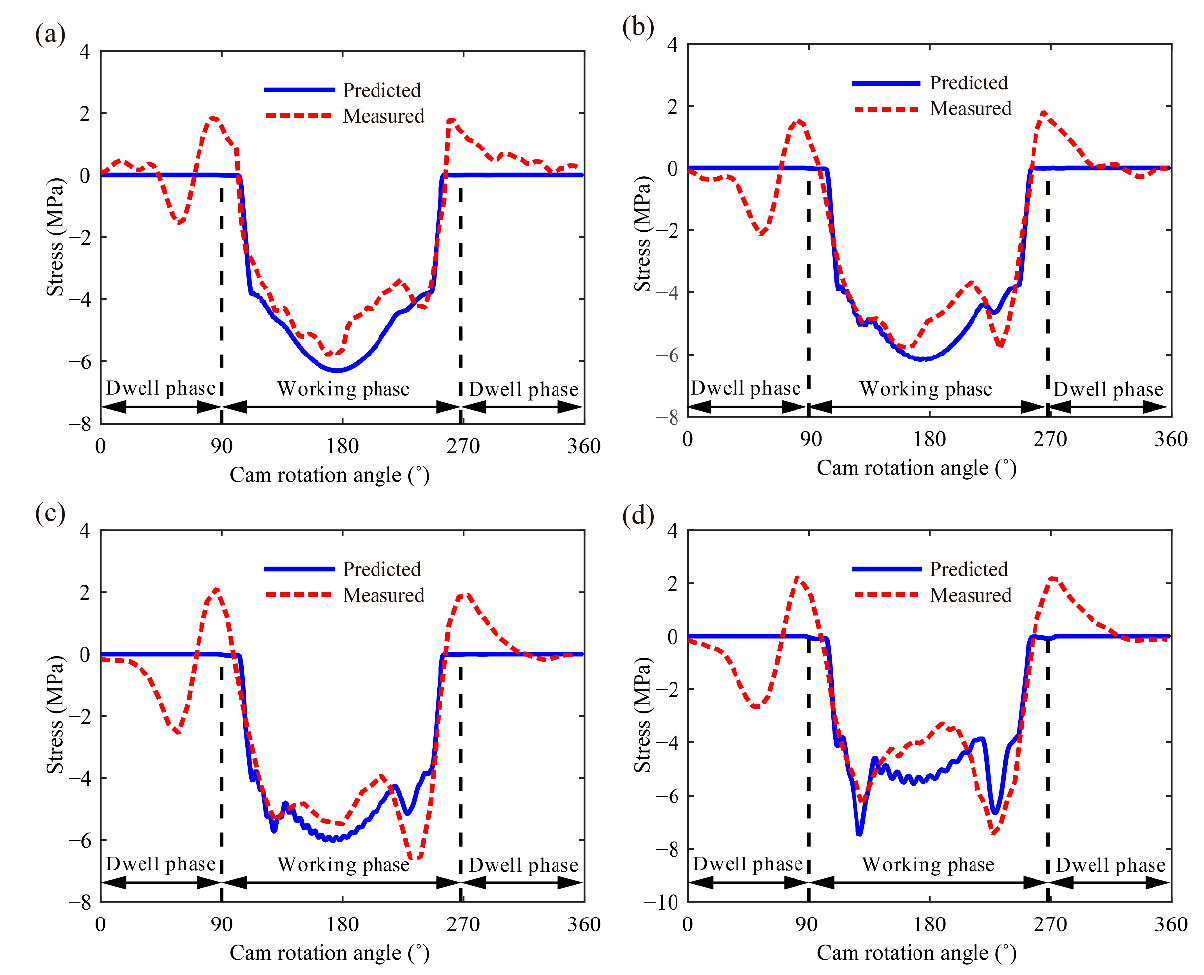
Figure 6. Predicted and measured stresses at ( a ) 600, ( b ) 900, ( c ) 1200 and ( d ) 1800 rpm. The value of the predicted stress is approximately 0 during the dwell phase at four different cam rotation speeds. However, although the measured data have been processed by using the time-domain synchronous averaging method, large peaks appear in the measured curves, and the tensile stress also appears during the dwell phase. In fact, the pushrod only bears pressure. The elastic compression of the pushrod releases rapidly and results in a transitory stretch, thereby causing the tensile stress. However, the predicted model does not yet take this into account, which causes the existence of differences between the predicted and measured